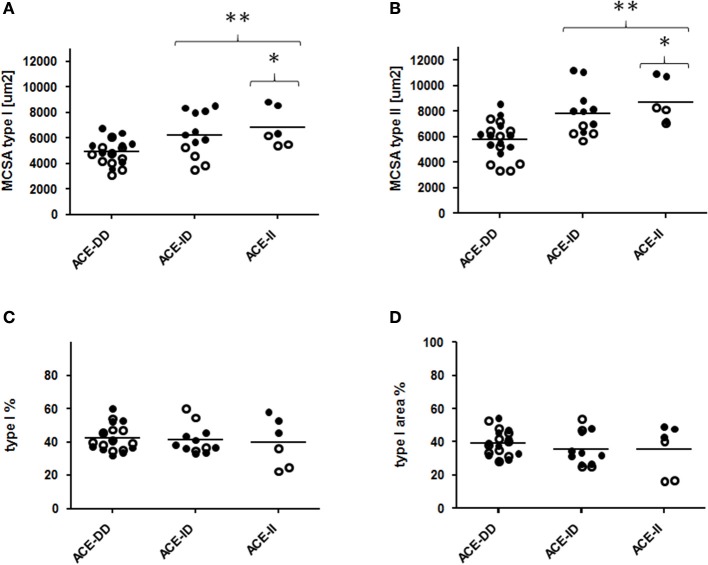
Effect of ACE-I/D genotype on muscle fiber structure. Scatter dot plot of the individual values and means (horizontal lines) of mean cross-sectional area (MCSA) of type I and II muscle fibers (A,B), distribution (C) and area percentage (D) of type I muscle fibers for the 52 studied subjects when split for ACE-I/D genotype (26xACE-DD, 20xACE-ID, 6xACE-II). Filled and non-filled symbols in A, B indicate values of the trained and untrained subjects, respectively. * and ** denote p < 0.05 and p < 0.01 vs. ACE-DD. Univariate ANOVA with post hoc test of Fisher. Only genotype effects are indicated.